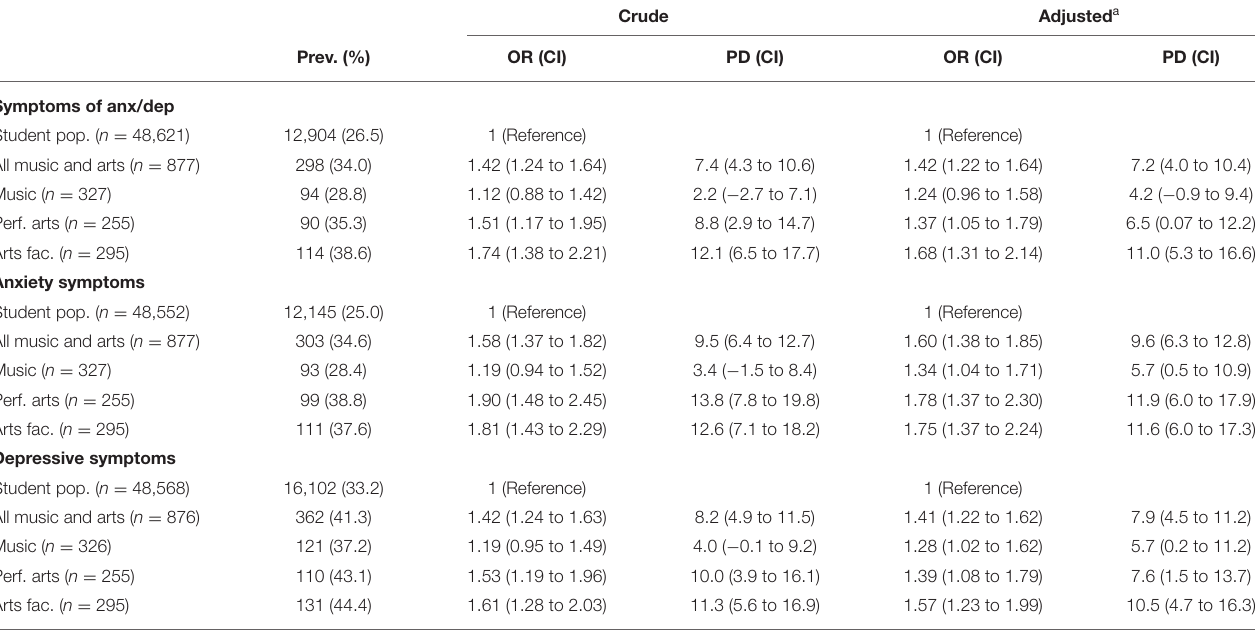
TABLE 2 | Logistic regression analysis of prevalence of symptoms of self-reported anxiety and depression symptoms in Norwegian music and arts students compared to the general student population.